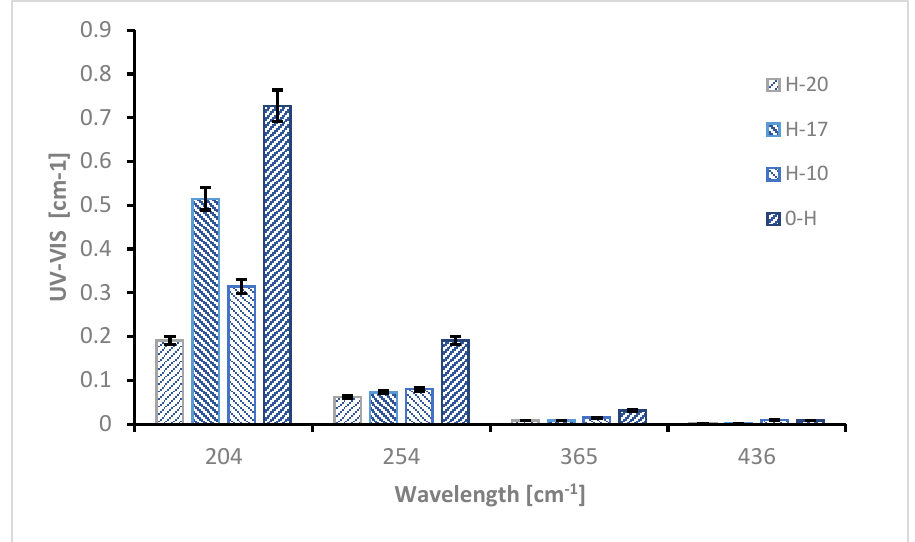
Figure 8. Data variability in ultraviolet absorption spectra in permeates for pristine membrane (H-0), adsorbent surface loading of 10 g/m 2 (H-10), 17 g/m 2 (H-17) and for 20 g/m 2 (H-20).